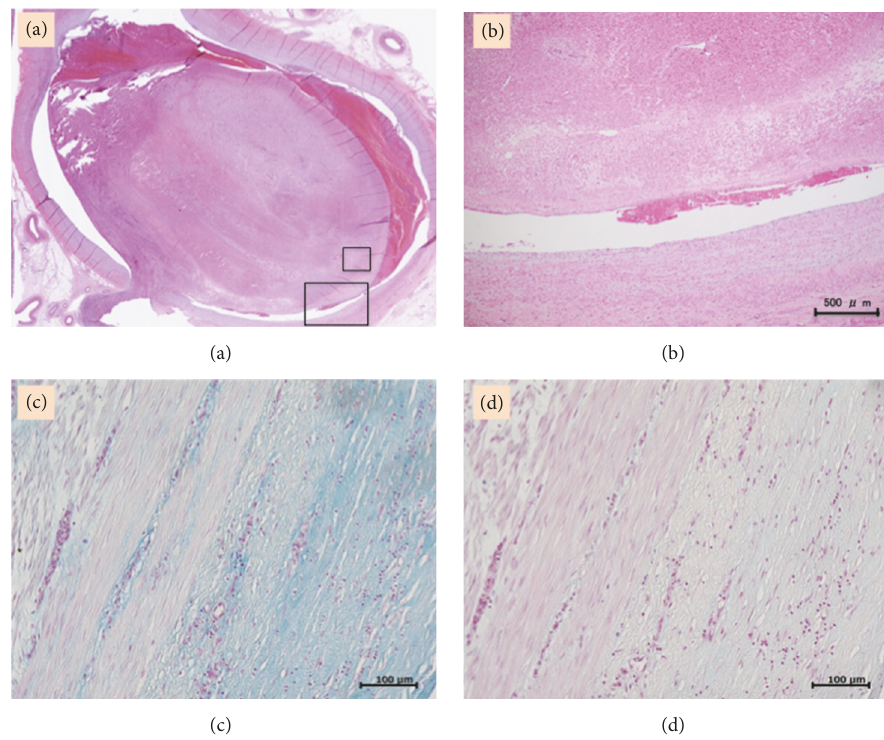
Figure 3: (a) The intravenous tumor (H&E magnifying lens). (b) Vessel endothelium cells and vascular smooth muscle layer covered the intravenous leiomyoma (H&E 40 × ); an enlarged view of the area in Figure 3(a) is surrounded by a large black box. (c) Tumor cells stained strongly for positive Alcian blue at a pH of 2.5 (200 × ); an enlarged view of the area in Figure 3(a) is surrounded by a small black box. (d) Alcian blue staining disappears after hyaluronidase digestion (200 × ); the same area as that in Figure 3(c) is